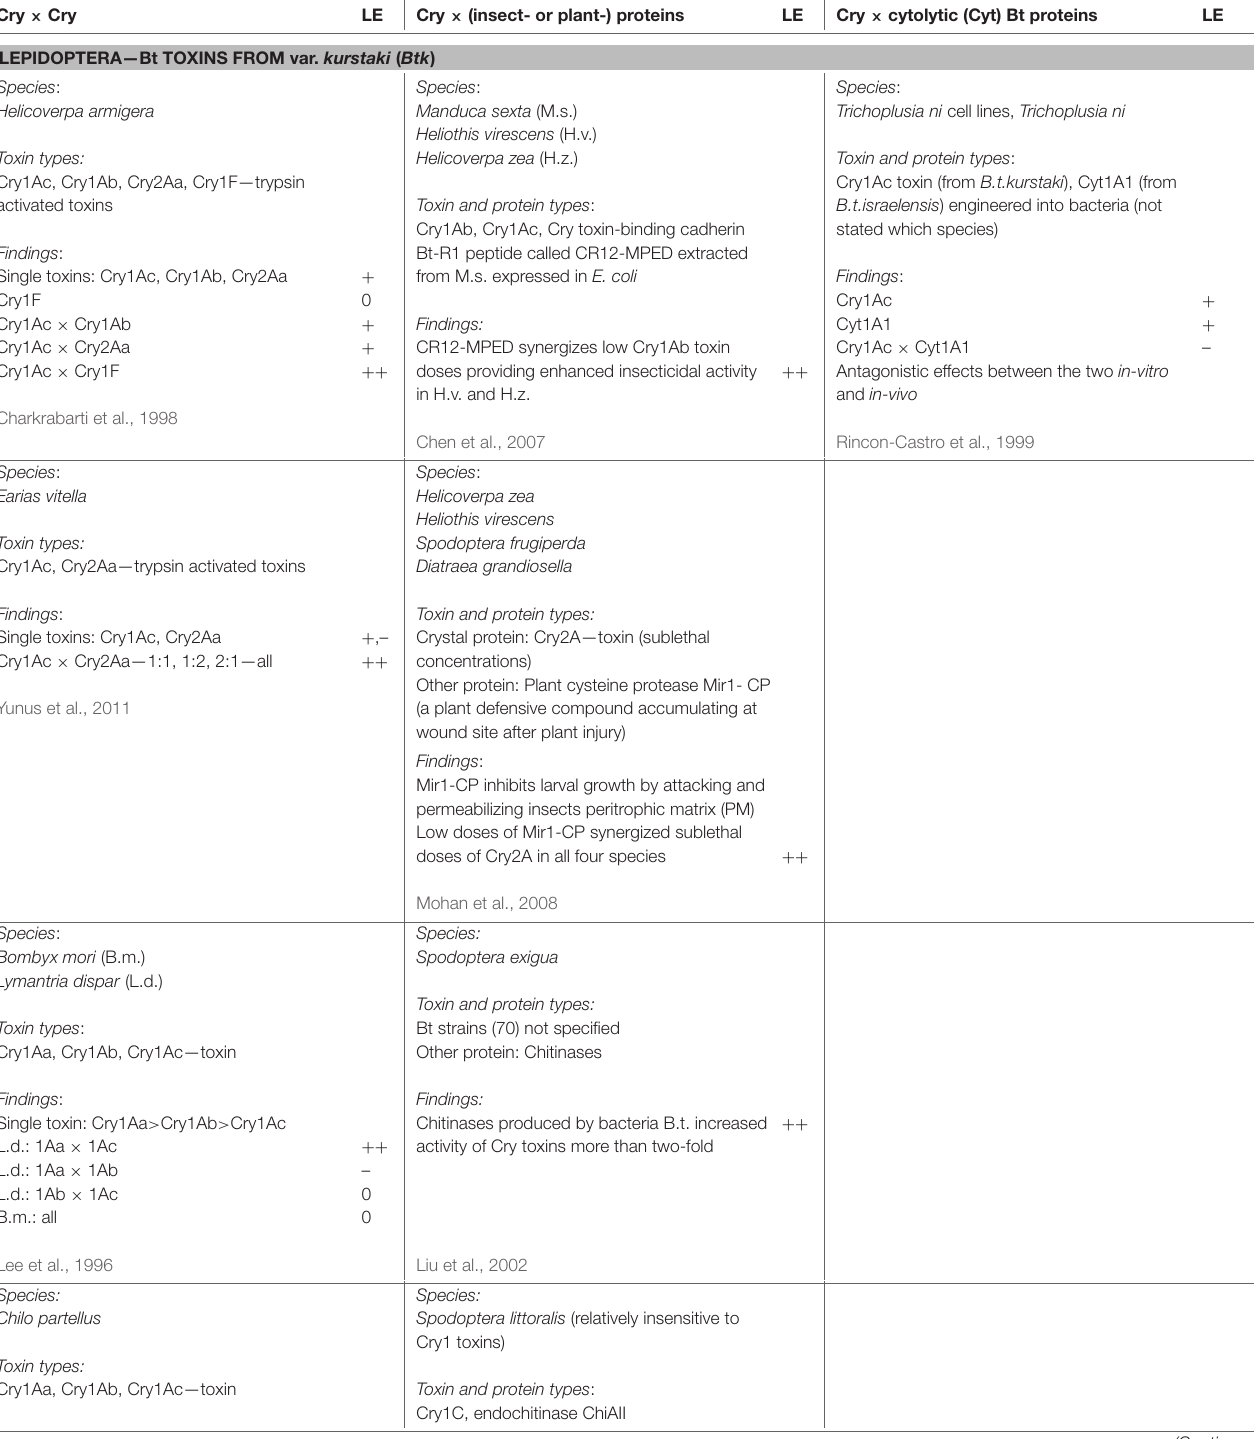
TABLE 2 | Some key publications highlighting different types of combinatorial effects on insects reported in the scientific literature. Cry × Cry LE Cry × (insect- or plant-) proteins LE Cry × cytolytic (Cyt) Bt proteins LE LEPIDOPTERA—Bt TOXINS FROM var. kurstaki ( Btk